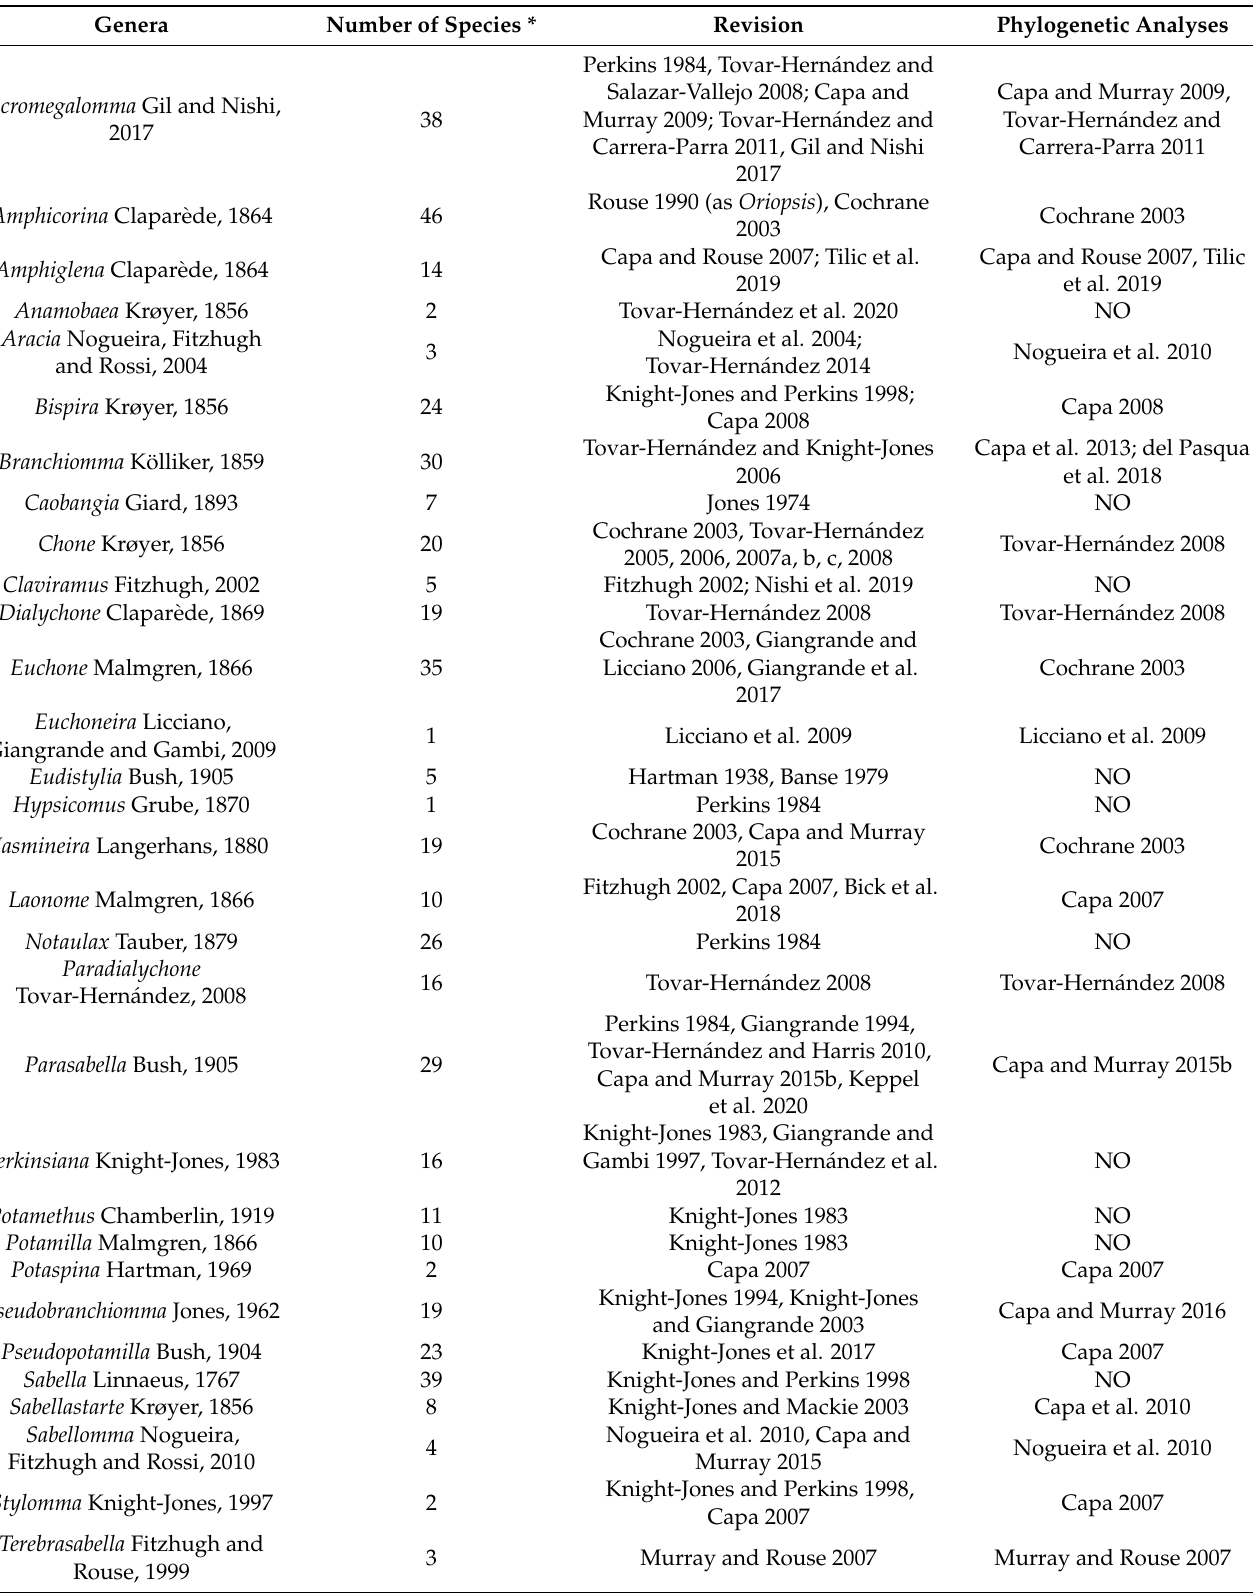
Table 3. Sabellid currently accepted genera that have gone through major or partial revisions and phylogenetic analyses (either considering morphological features, molecular data or